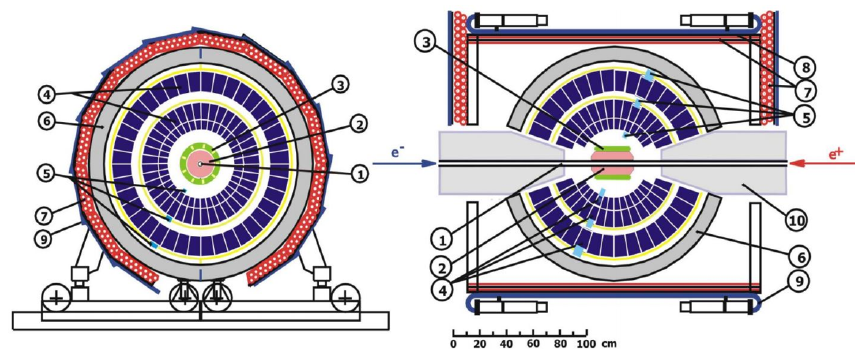
Figure 2: The SND detector. 1 – vacuum chamber, 2 – tracking DC, 3 – aerogel n = 1.13, 1.05, 4 – NaI(Tl) crystals, 5 – phototriodes, 6 – absorber, 7 – muon detector, 10 – SC